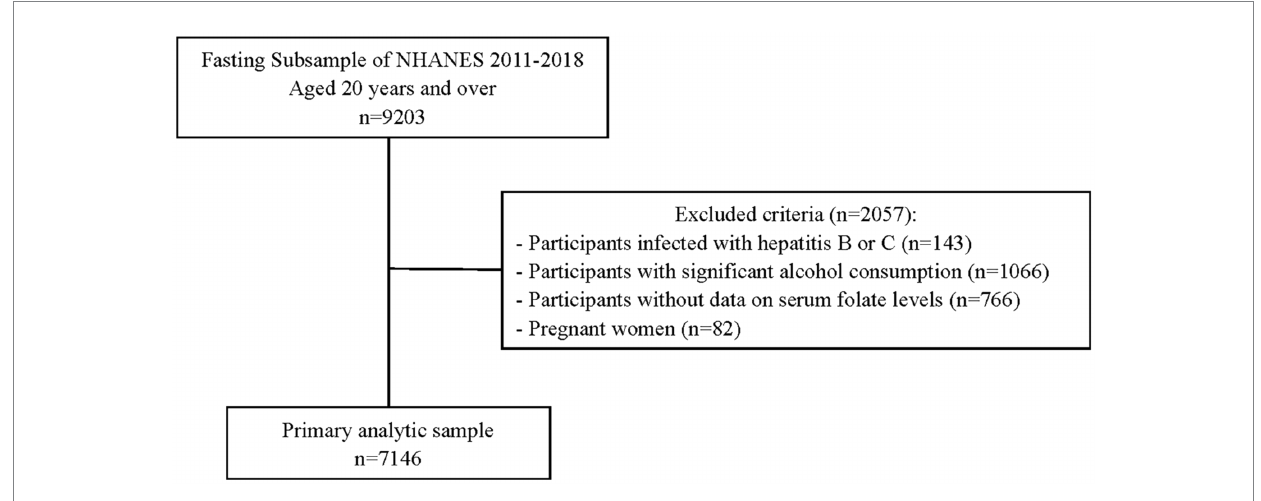
FIGURE 1 Flowchart of the sample